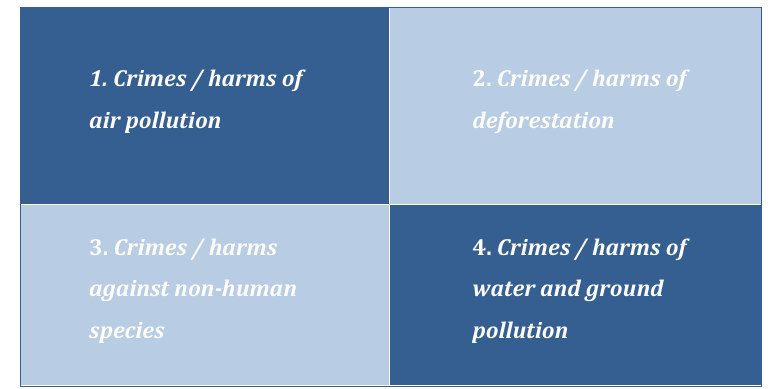
Figure 1: Example of green crimes and harms clusters responsible for direct